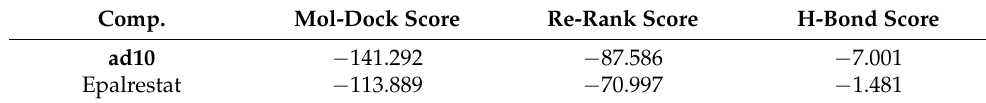
Table 33. Hypoglycemic effect of the compound ad10 depicted by docking score.